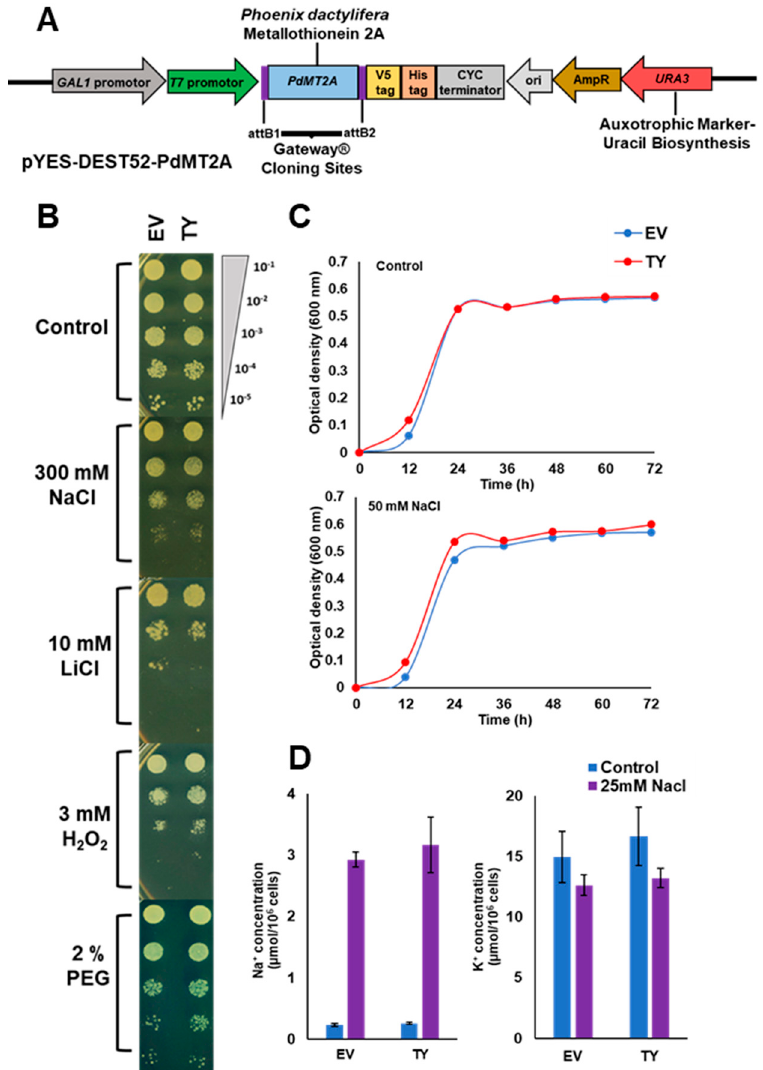
Figure 3. Overexpression of PdMT2A in yeast. Schematic representation of the cloned PdMT2A gene within the pYES-DEST52 plasmid ( A ). The effect of the PdMT2A transgene on the growth of yeast cells and the relative tolerance of transgenic (TY) and empty vector (EV) cells tested by yeast spot assay when grown under control and various abiotic stress conditions on solid media ( B ). Yeast liquid culture assay used to test the relative tolerance of TY and EV cells grown under control and 50 mM NaCl stress conditions ( C ). Accumulation of Na + and K + in TY or EV cells when grown under control and 25 mM NaCl salinity stress conditions ( D ). The bars represent the mean concentration of Na + and K + (± SE, n = 3).